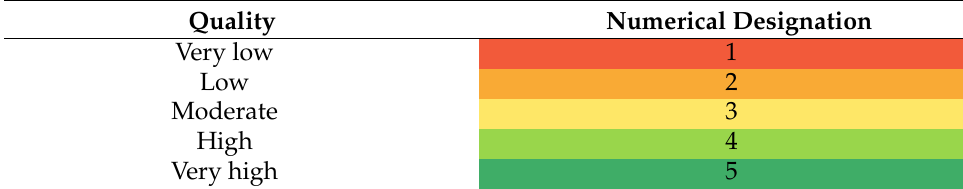
Table 16. Numerical designation of the qualities awarded to each technology for the given